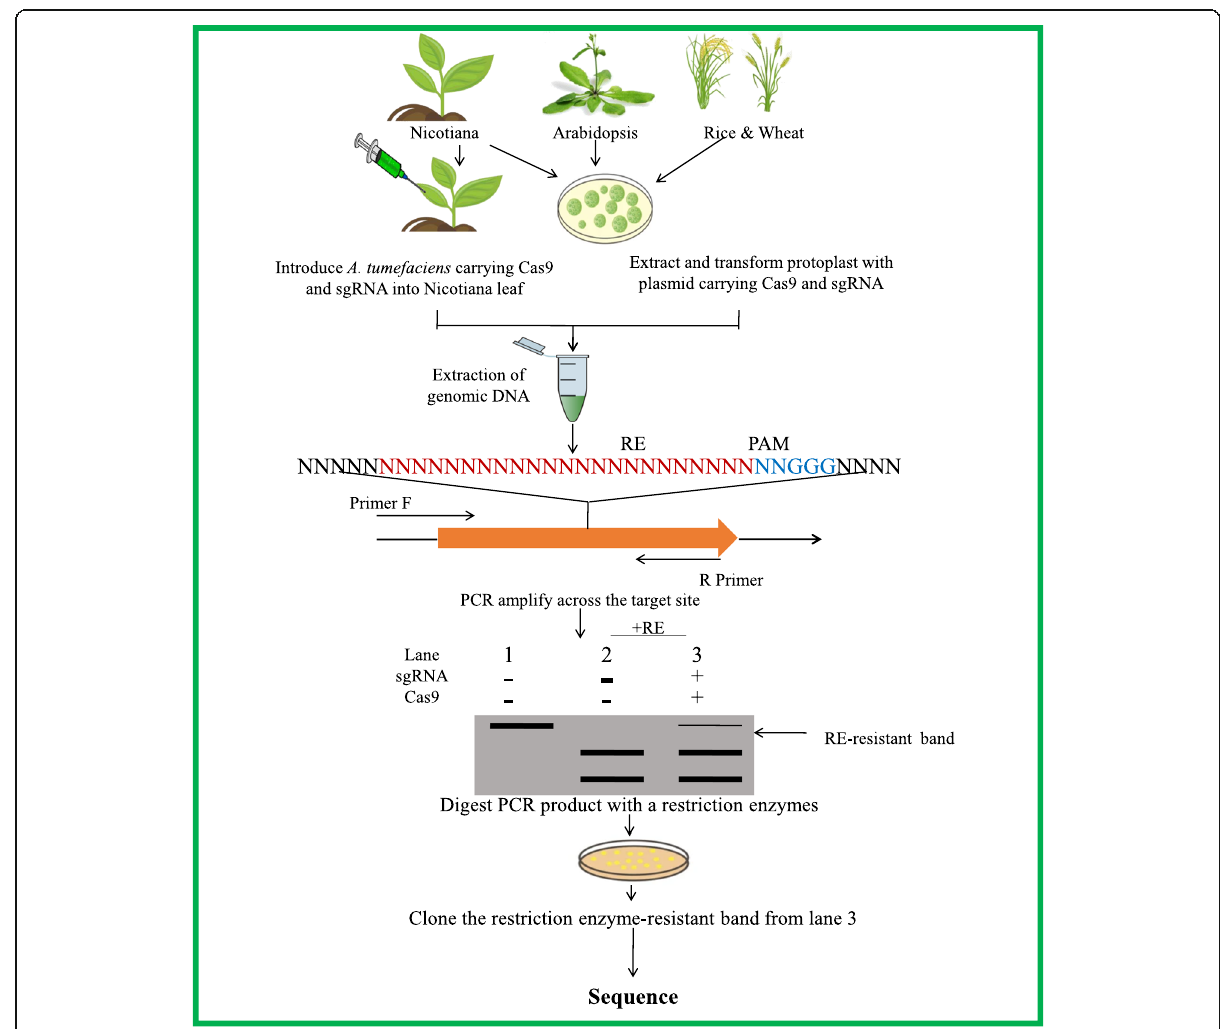
Fig. 5 A schematic drawing illustrating an example of genome editing for crop improvement through the CRISPR/Cas9